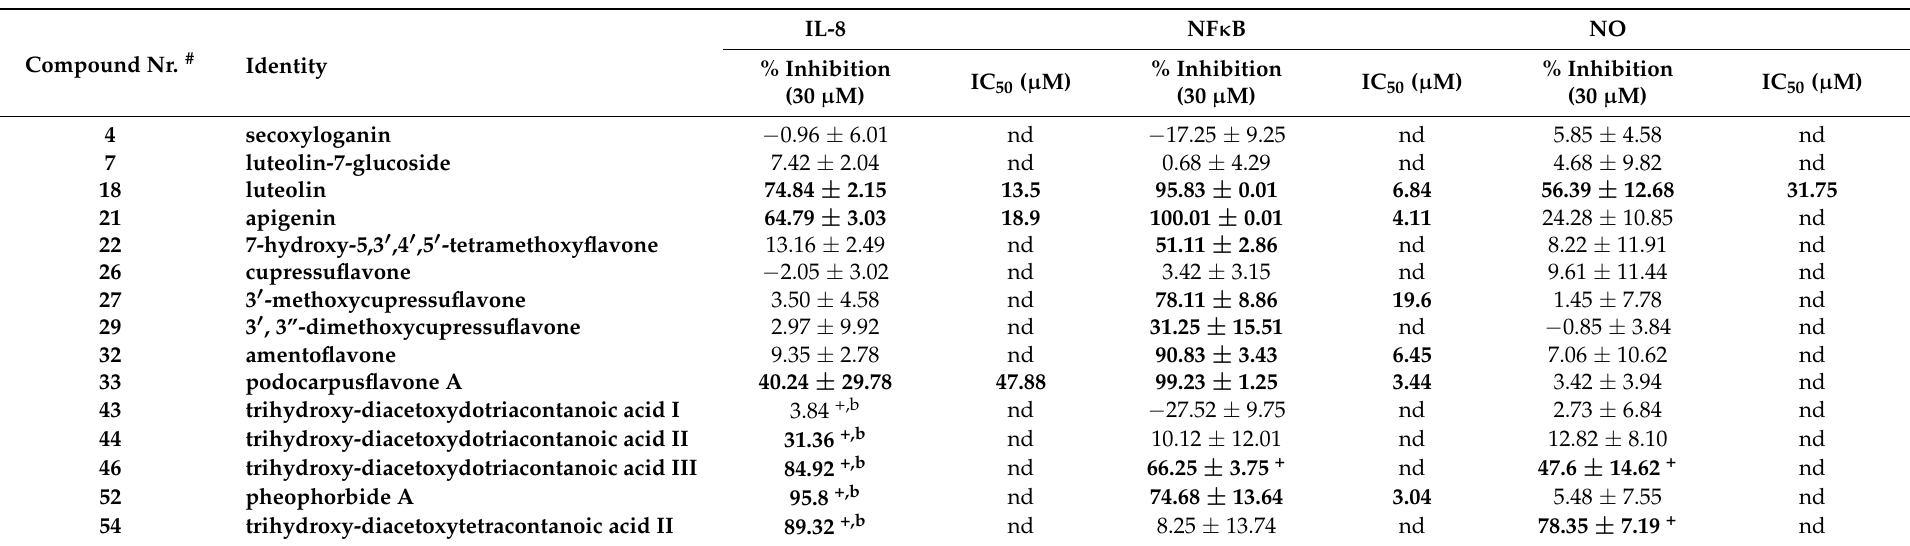
Table 5. Inhibitory activities of selected OPLS-DA hit compounds in cellular inflammation assays. # Compound numbers and identification; see Table 2. Effect on NF- κ B activation was assessed in HEK/NF κ B-luc cells stimulated with TNF- α ; positive control: parthenolide (5 µ M); results are given as means ± SD of 4 replicates (each in quadruplicate); IL-8 expression was assessed in HUVECtert cells stimulated with LPS; positive control: Bay 11-7082 (7.5 µ M); results are given as means ± SD of 5 replicates; b in compounds significantly impairing cell viability, IL8 expression was determined one sample prepared by pooling the 5 replicates.; + compound significantly impaired cell viability at concentration of 30 µ M; Effect on NO production was assessed in LPS/IFN γ -stimulated RAW macrophages. Extract concentration: 50 µ g/mL; positive control: L-NMMA (100 µ M); results are given as the means ± SD of 3 experiments performed in